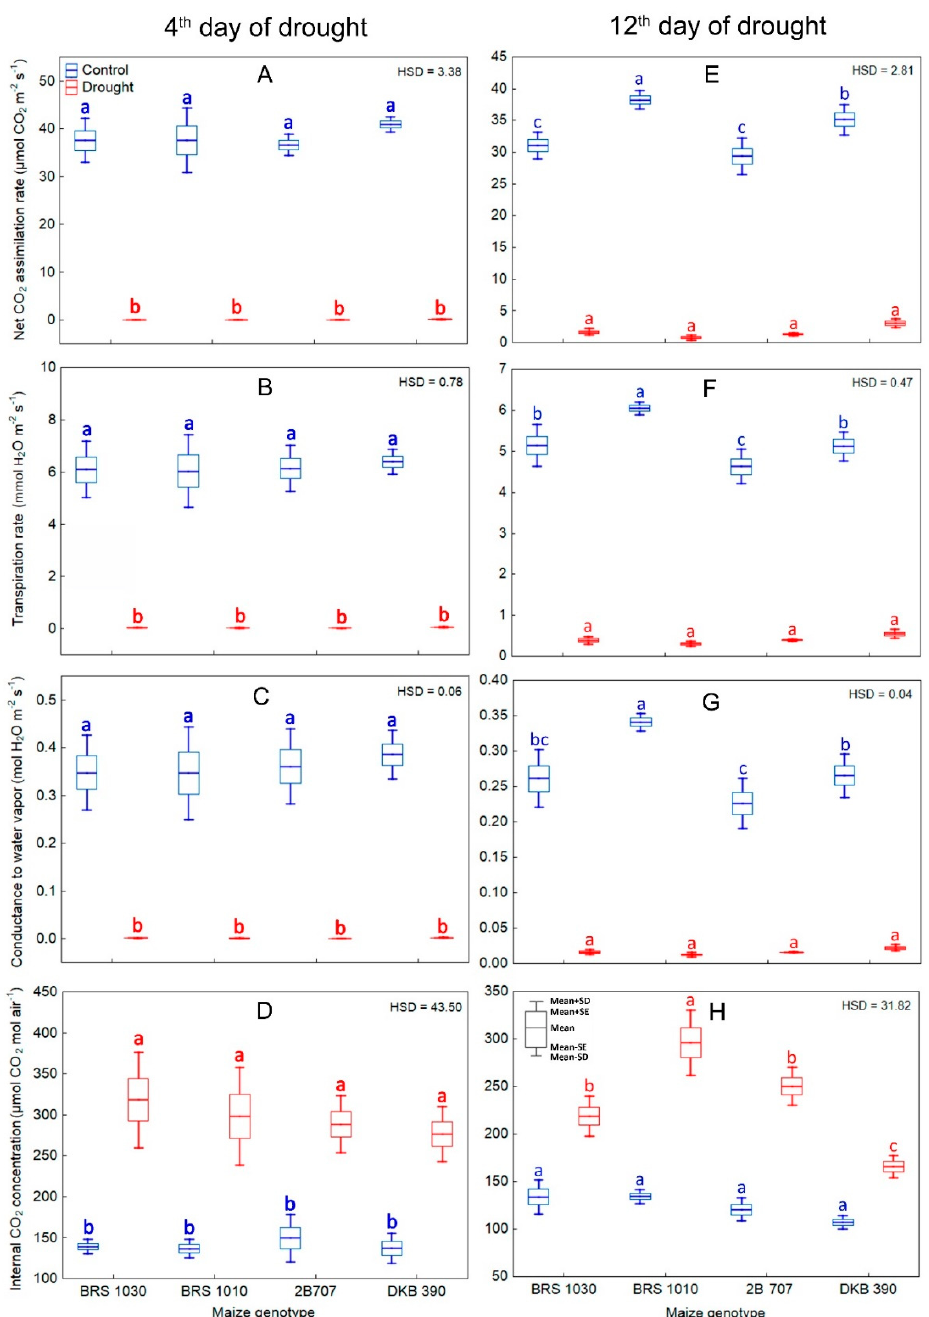
Figure 5. Gas exchange measurements for control and drought stressed maize plants in the 4th and 12th day of stress. ( A , E ) Net CO 2 assimilation rate, ( B , F ) Conductance to water vapor, ( C , G )